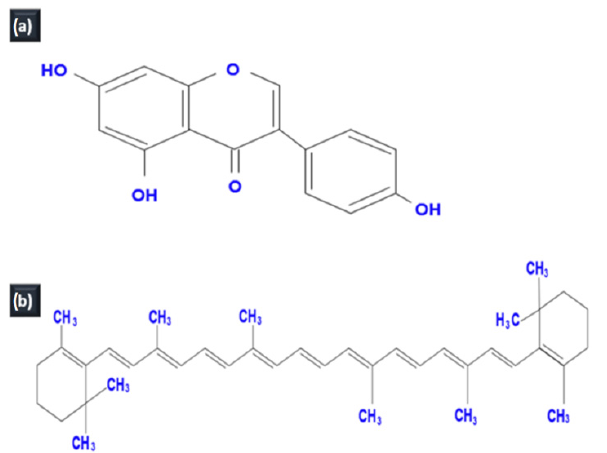
Figure 3. Illustration of the dyes reported in the literature of DSSC. ( a ) Carotenoids, ( b ) Flavonoids.